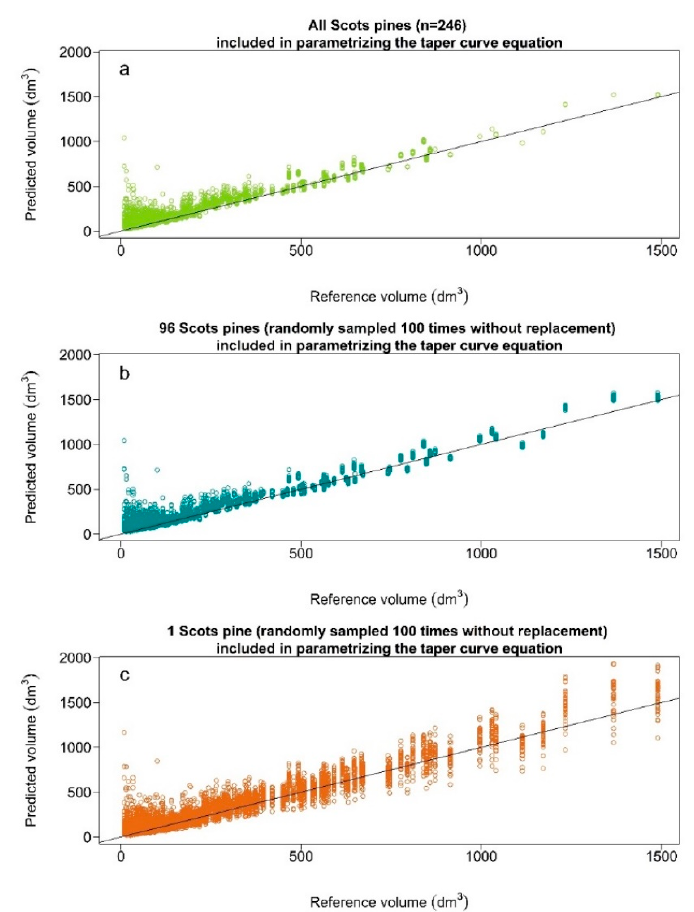
Figure 10. Reference stem volume and predicted stem volume based on the taper curve equation that was parametrized using all ( n = 246) Scots pines ( a ), or random sample of 96 ( b ) and 1 Scots pine ( c ). Additionally, predicted volume includes random sampling of 100 Scots pine for validation to show the variation in the stem-volume estimates. Black line presents 1:1 relationship.